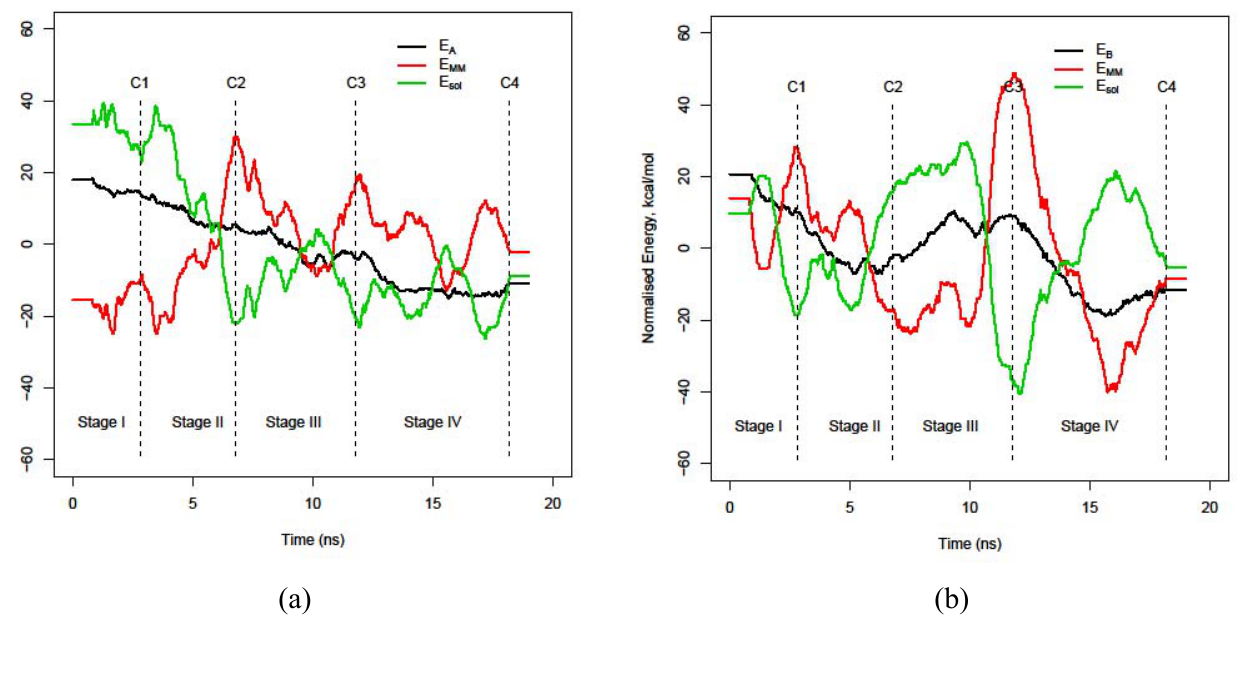
= E + E and (b) E A MM,A sol,A